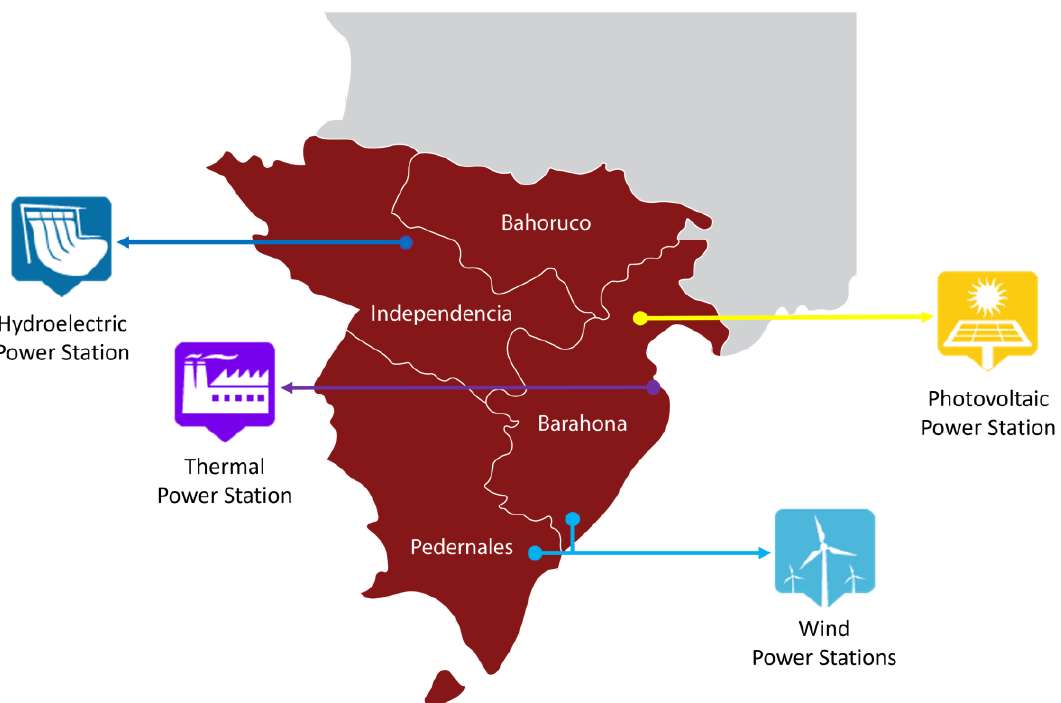
Figure 2. Location of the Enriquillo Region, Dominican Republic. Source: https://www.mapas.cne. gob.do/ (Accessed on 15 February